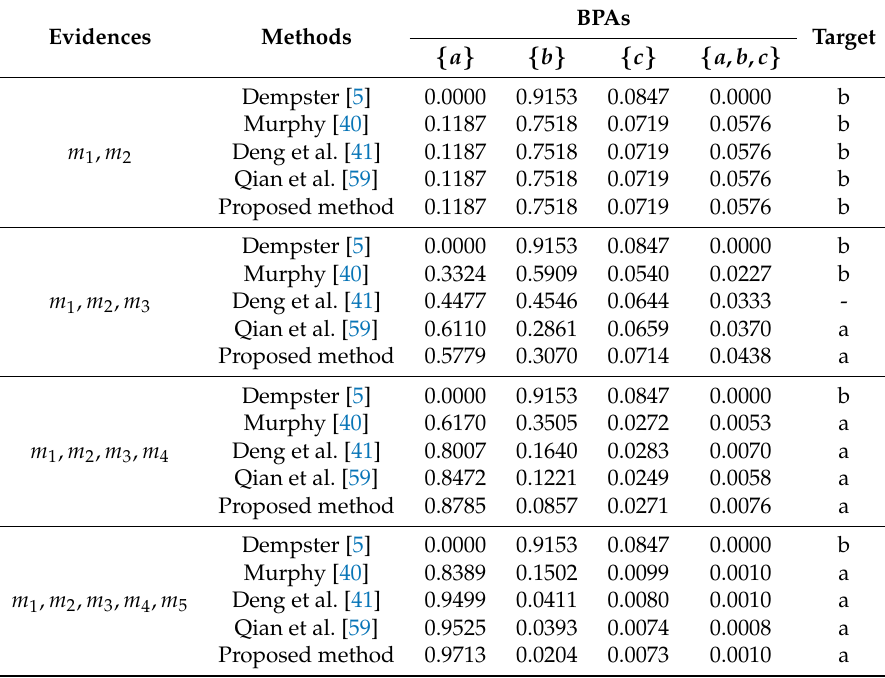
Table 4. Evidence fusion results based on different combination